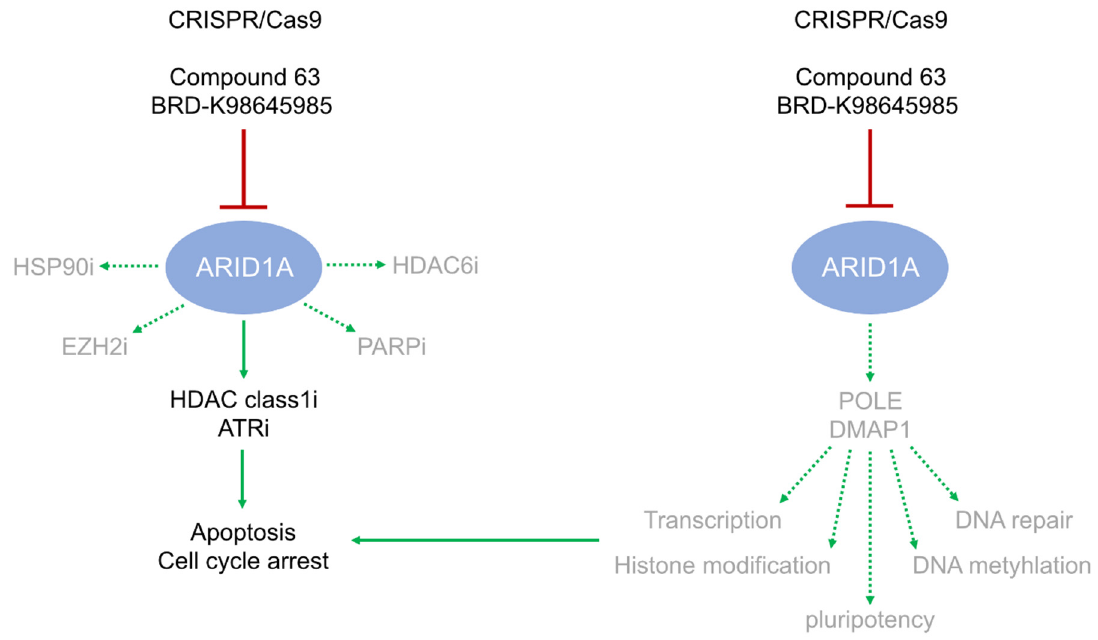
Figure 4. Illustration of the effects of ARID1A inhibition and molecular functions of ARID1A. Deficiency or pharmacological inhibition of ARID1A sensitizes GCTs cells slightly to HDAC class 1 inhibitor romidepsin and more prominently to ATR inhibition, causing a reduction in viability, apoptosis, and cell cycle arrest (left side). On a molecular level, ARID1A normally regulates transcription, DNA repair, DNA methylation, histone modifications and the pluripotency program at least in parts via POLE and DMAP1 (right side). These regulatory cascades diminish upon inhibition of ARID1A, subsequently contributing to the induction of apoptosis and cell cycle arrest. Arrow: sensitization/activation; dotted arrow: no sensitization/diminished activation; T-shaped arrow: inhibition/inactivation.